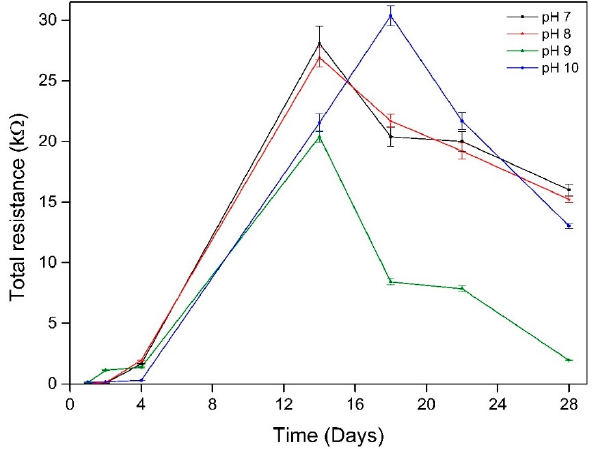
Figure 7. The evolution of total resistance of the working electrodes over time at different starting pH.